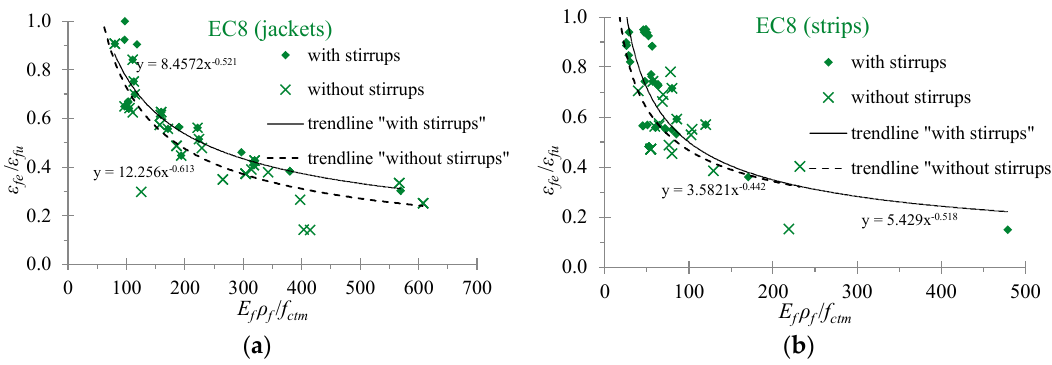
Figure 10. Effectiveness of the EB-FRP U-jacketing based on the provisions of the Eurocode 8 part 3: ( a ) U-shaped retrofitted T-beams with EB-FRP jackets; ( b ) U-shaped retrofitted T-beams with EB-FRP strips.